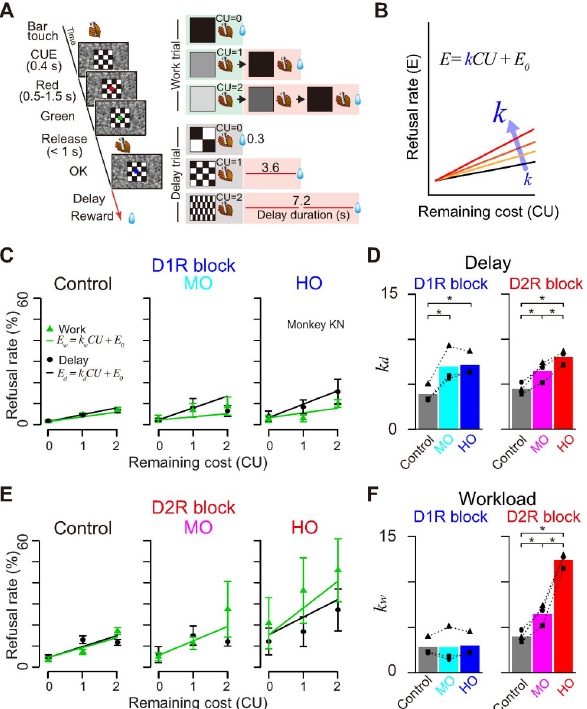
Fig 5. Differential effects of D 1 R and D 2 R blockade on cost-based motivational valuation. (A) The work/delay task. The sequence of events (left) and relationships between visual cues and trial schedule in the work trials (right top 3 rows) or delay duration in the delay trials (right bottom 3 rows) are shown. CU denotes the remaining (arbitrary) cost unit to get a reward, i.e., either remaining workload to perform trial(s) or remaining delay periods. (B) Schematic illustration of an explanatory model of increases in refusal rate by increasing cost sensitivity ( k ). (C) Effects of D 1 R blockade. Representative relationships between refusal rates (monkey KN; mean ± SEM) and remaining costs for workload (green) and delay trials (black). Saline control (Control) and moderate (30 μ g/kg; MO) and high D 1 R occupancy treatment condition (100 μ g/kg; HO) are shown. Green and black lines are the best-fit lines for work and delay trials in model #1 in S3 Table, respectively. (D) Effects of D 2 R blockade. Nontreatment control (Control), moderate (1 day after haloperidol; MO) and high D 2 occupancy treatment conditions (day of haloperidol; HO) are shown. Others are the same for C. (E) Comparison of effects between D 1 R and D 2 R blockade on delay discounting ). Bars and symbols indicate mean and individual data, respectively. (F) Comparison of effects between parameter ( k d D 1 R and D 2 R blockade on workload discounting parameter ( k ). Asterisks represent significant difference ( � p < 0.05, w 1-way ANOVA with post hoc Tukey HSD test). The data underlying this figure can be found on the following public repository: https://github.com/minamimoto-lab/2021-Hori-DAR. D 1 R, D 1 -like receptor; D 2 R, D 2 -like receptor; HO, high occupancy; HSD, honestly significant difference; MO, moderate